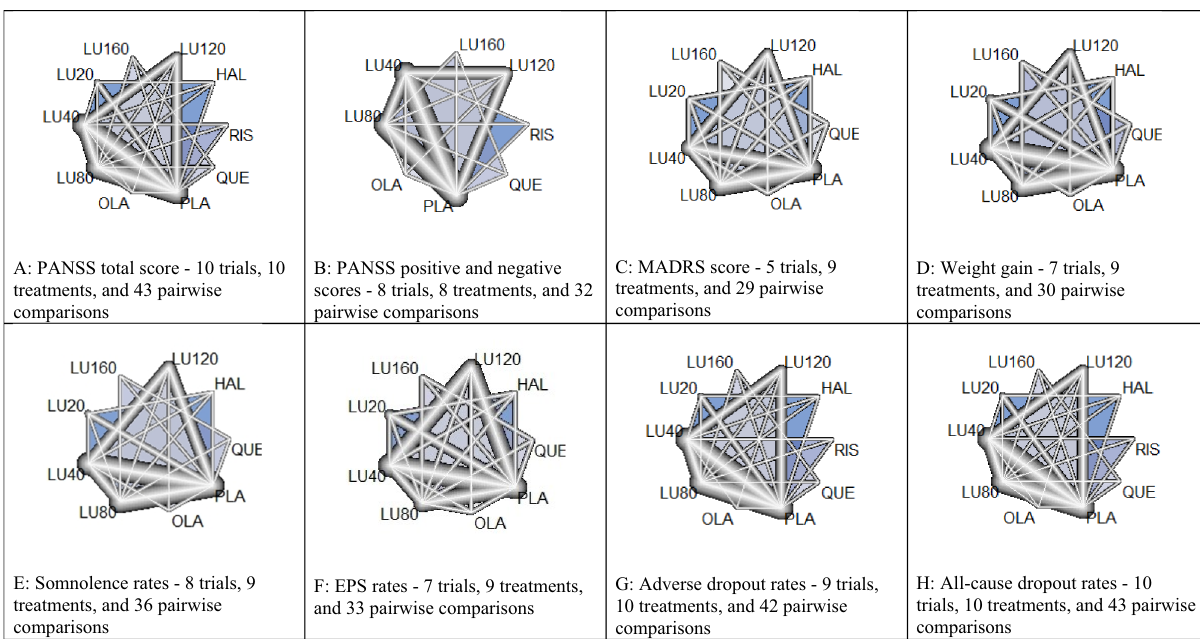
Figure 2. Network plots of five different doses of lurasidone, other antipsychotics, and placebo for acute schizophrenia. The nodes in the graph layout correspond to lurasidone at various doses, other antipsychotics, and placebo. Lines display the observed treatment comparisons. The thickness of edge indicates the number of comparisons. Gray/blue areas indicate the availability of trials with three doses or more. PANSS: Positive and Negative Syndrome Scale; MADRS: Montgomery-Asberg Depression Rating Scale; EPS: extrapyramidal symptoms. HAL: Haloperidol; LU20: Lurasidone 20 mg/day; LU40: Lurasidone 40 mg/day; LU80: Lurasidone 80 mg/day; Lurasidone 120 mg/day; Lurasidone 160 mg/day; OLA: Olanzapine; PLA: Placebo; QUE: Quetiapine; RIS: